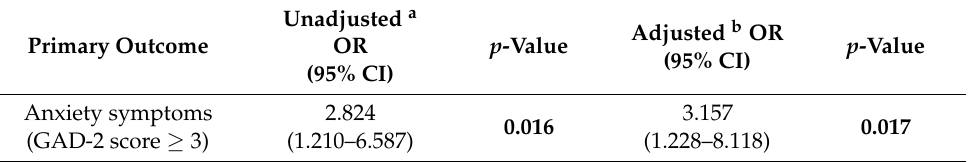
Table 3. Logistic regression analysis for Model 2: association of the willingness to receive the vaccine with psychological distress assessment